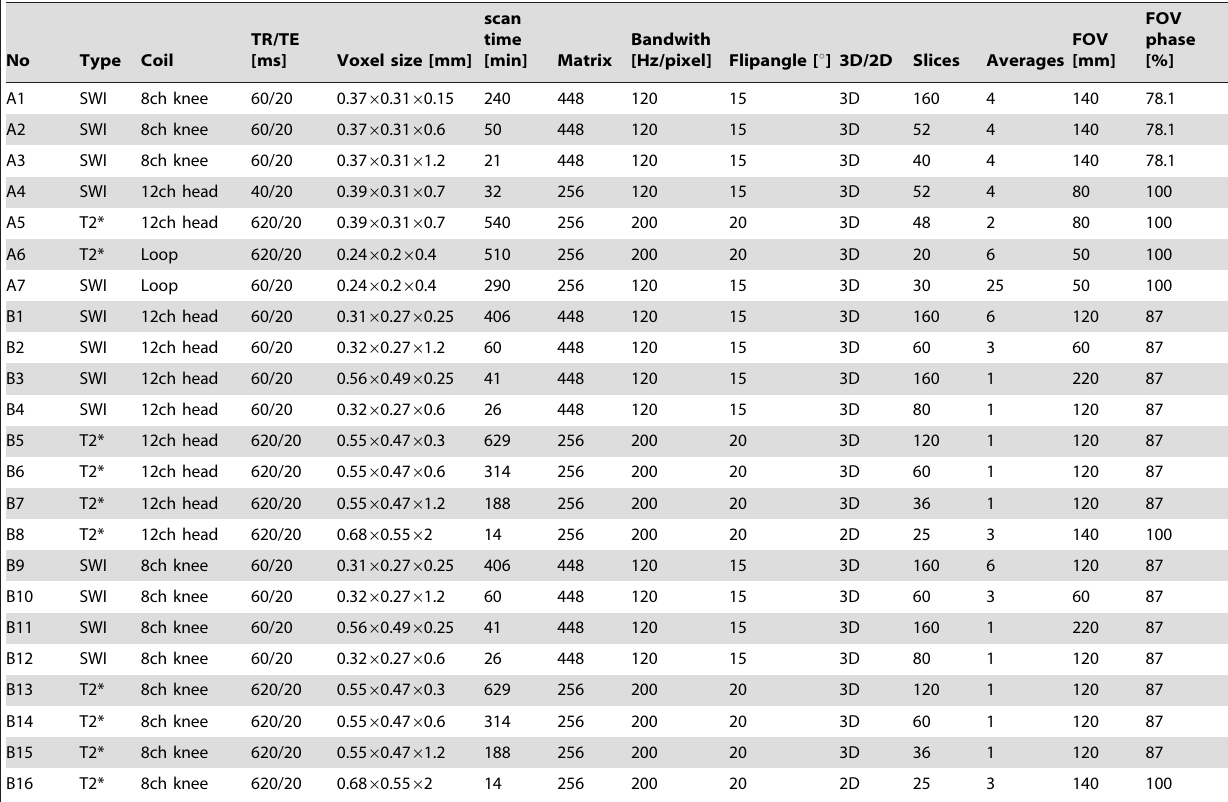
Table 1. Sequence parameters.